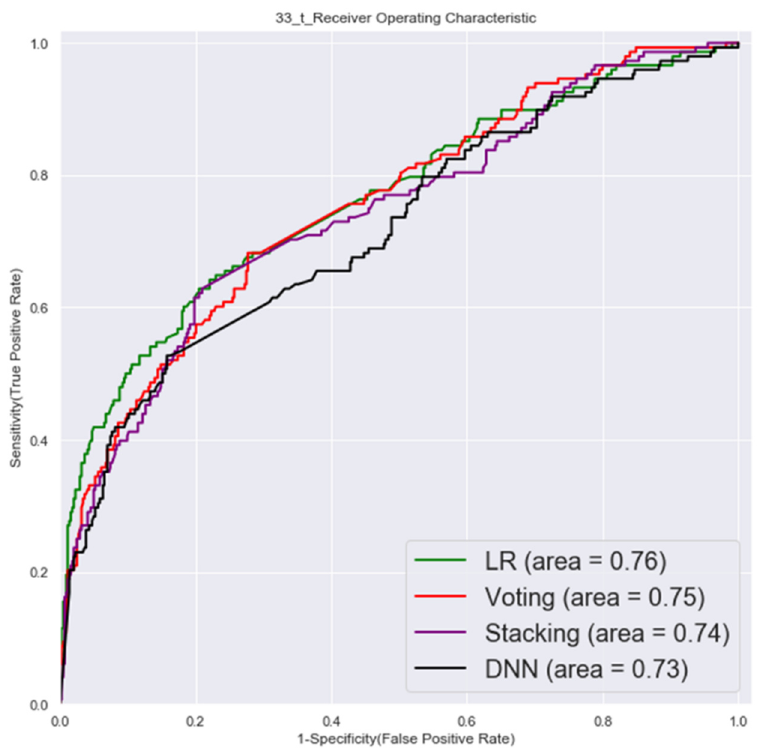
Figure 3. Validation set ROC (first factor combinations).